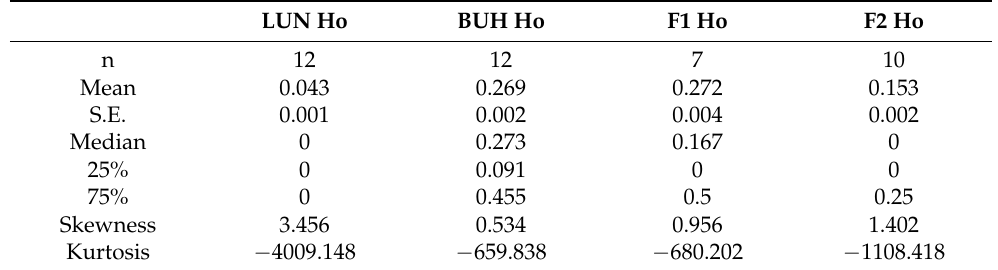
Table 1. Summary of the observed heterozygosity (Ho) (estimated from 8184 linkage-disequilibrium- pruned loci) from each of the 4 dog groups: Lundehund (LUN), Buhund (BUH), first-generation crosses LUN × BUH (F1) and first-generation backcrosses F1 × Lundehund (F2). The number of individuals sampled in each group (n), the mean Ho, the standard error of the mean (S.E.), the median Ho, the 25% and 75% percentiles, the skewness and the kurtosis of the Ho distributions are shown. LUN Ho BUH Ho F1 Ho F2 Ho n 12 12 7 10 Mean 0.043 0.269 0.272 0.153 S.E. 0.001 0.002 0.004 0.002 Median 0 0.273 0.167 0 25% 0 0.091 0 0 75% 0 0.455 0.5 0.25 Skewness 3.456 0.534 0.956 1.402 Kurtosis − 4009.148 − 659.838 − 680.202 −